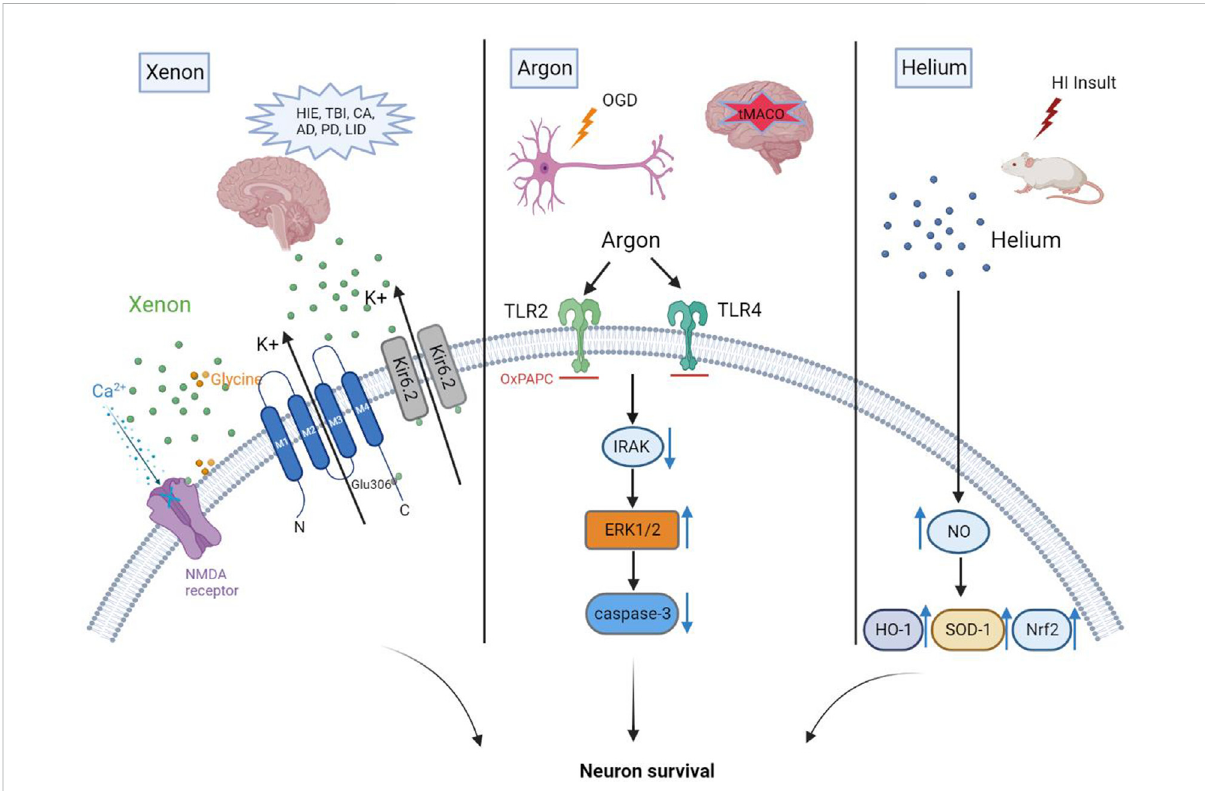
FIGURE 1 XenonyieldsneuroprotectionmainlyduetoitsinhibitionataglycinesiteofNMDAreceptors.Neuroprotectionmediatedbyargonislinkedtoits inhibition of TLR2 and TLR4. Helium preconditioning upregulates the anti-oxidases mediated by nitric oxide (NO) to produce neuroprotective